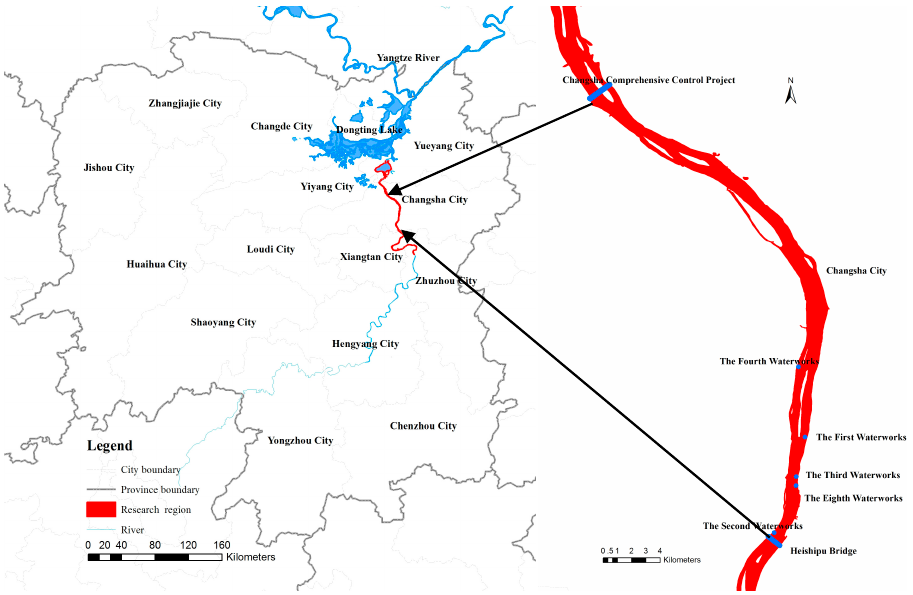
Figure 1. Channel plan in the lower reaches of the Xiangjiang River (the left panel shows the map of Hunan Province, and the right panel illustrates the reach).